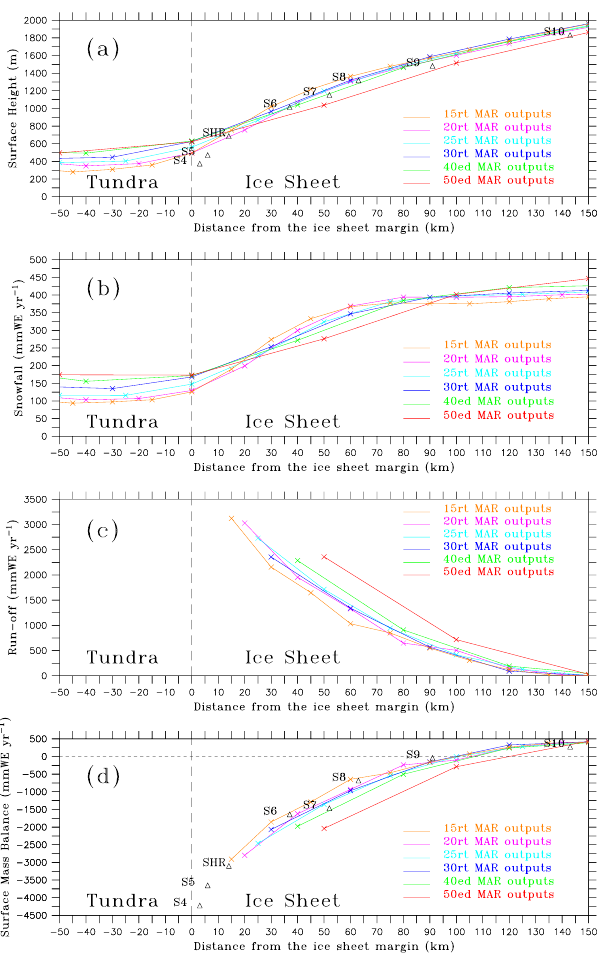
Fig. 1. (a) Cross section of surface height (m) through the GrIS along the K-transect (67 ◦ N, West Greenland) for the 15–50km resolution MAR runs, with station data drawn in black symbols. (b) The same as (a) , but for annual snowfall (mmWEyr − 1 ) over the 1990–2010 period. (c) The same as (b) , but for the annual run- off of meltwater (mmWEyr − 1 ). (d) The same as (b) , but for the annual SMB (mmWEyr − 1